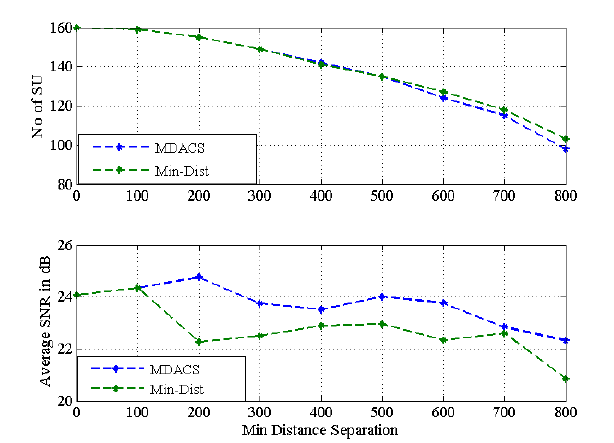
Figure 8. Evaluation of minimum distance algorithm for two different sets of distribution (a) Optimization algorithm for normal distribution (b) optimization algorithm for uniform distribution.